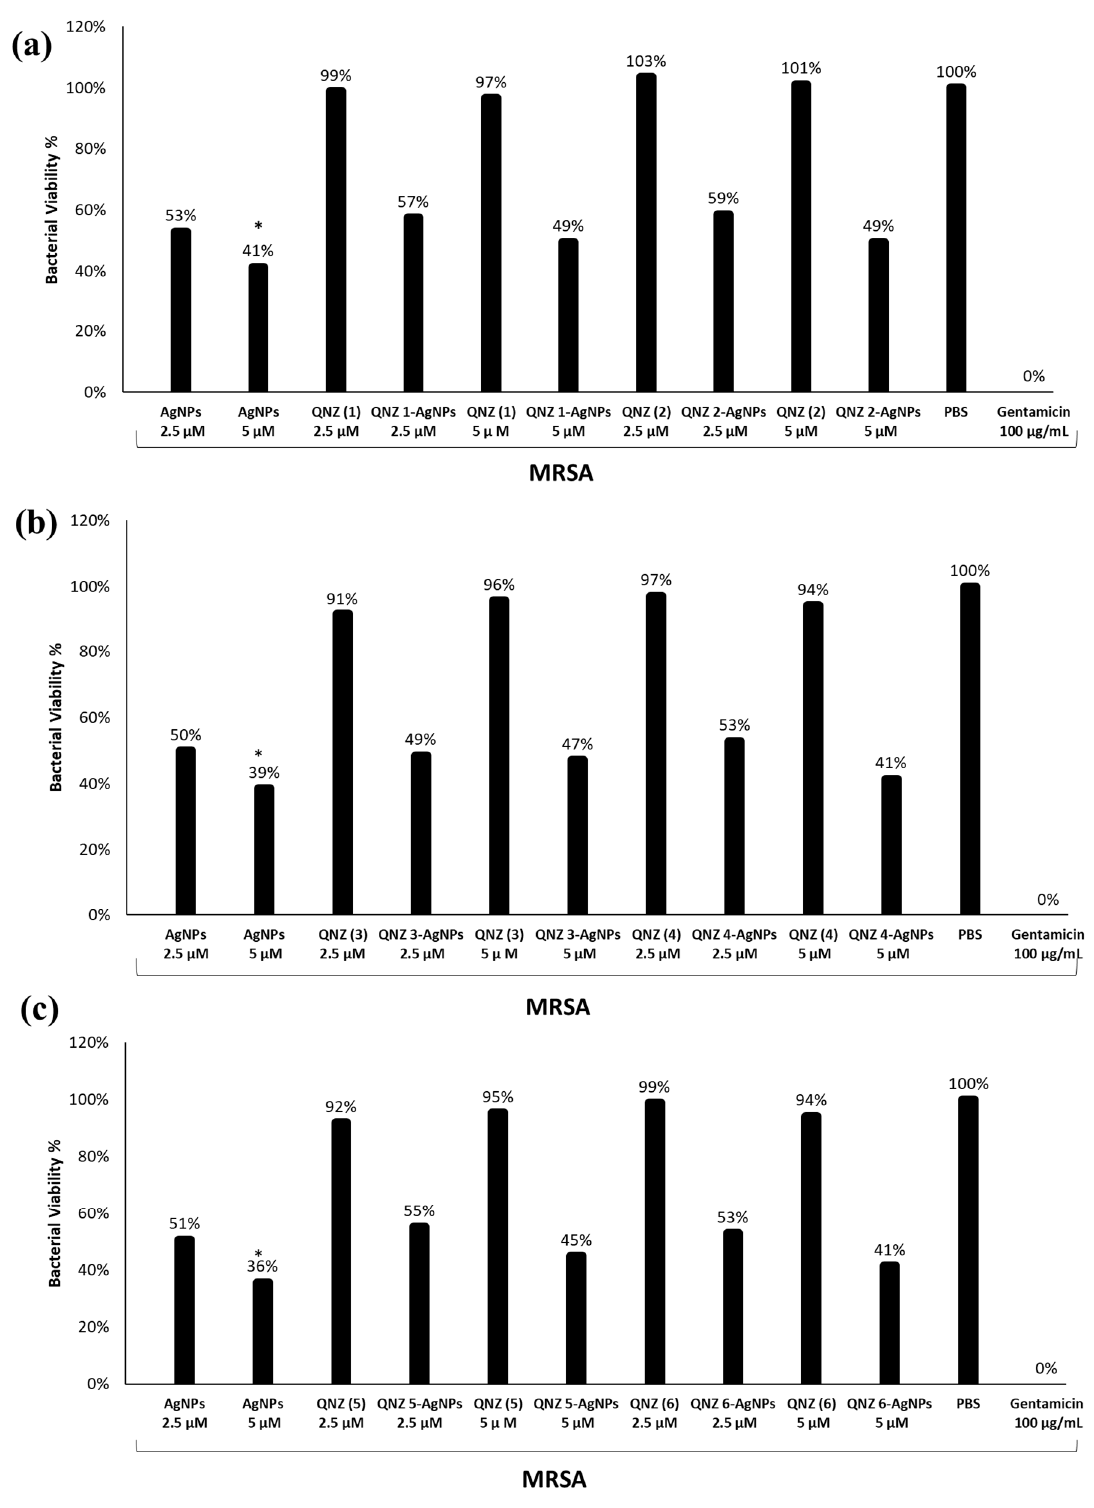
Figure 6. Bactericidal assay against MRSA ( a – c ). Note that all nanoconjugates did not exhibit bactericidal effects against MRSA. The results are presented as the mean ± standard error of various experiments performed in duplicate. * indicates p < 0.05 using two-sample t test and two-tailed distribution.